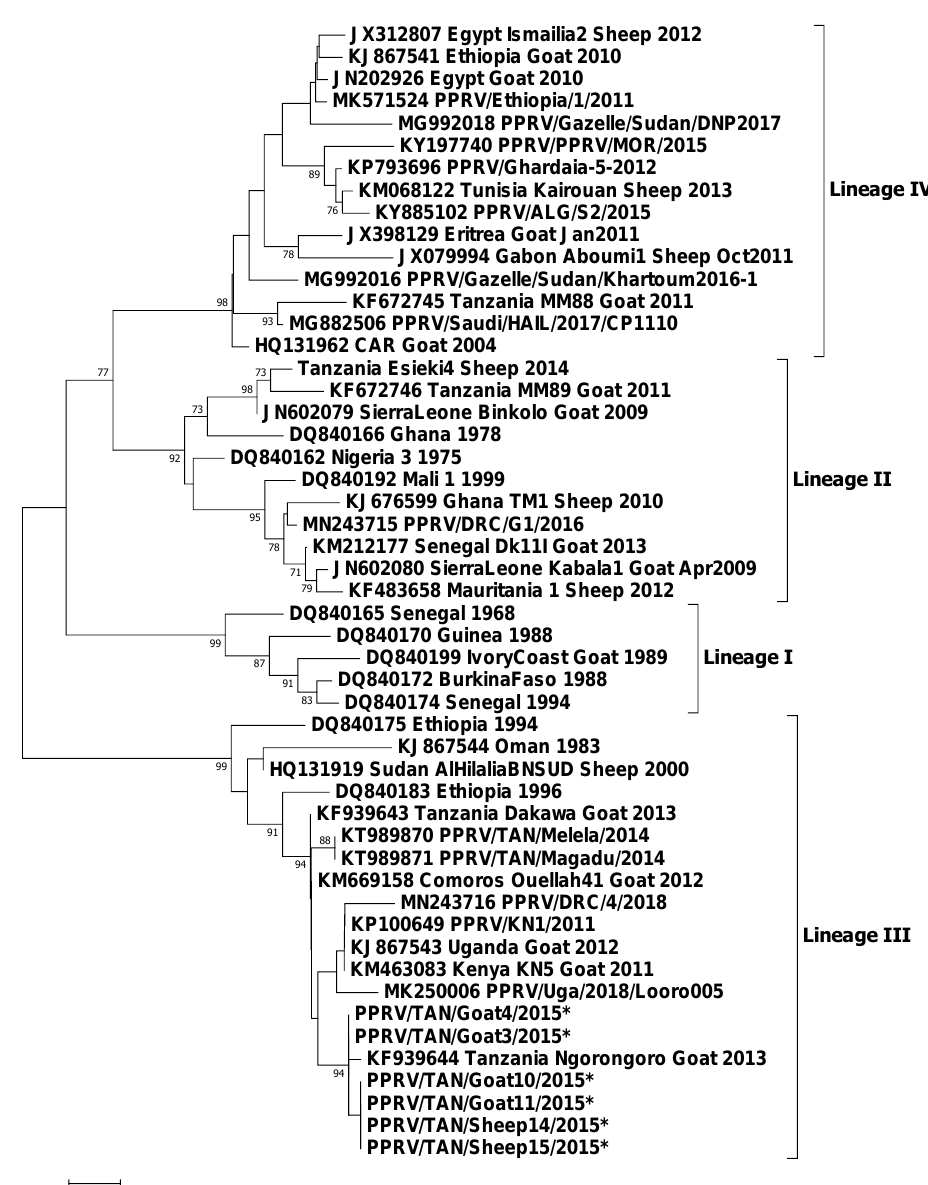
Figure 7. Neighbour-joining tree constructed on the basis of partial N gene sequences of the peste des petits ruminants virus (PPRV). The tree shows the relationships among the African PPRV isolates. The scale bar indicates nucleotide substitutions per site. The Kimura 2-parameter model with percentage of replicate trees in which the associated taxa clustered together in the 1000 bootstrap replicates is shown next to the branches. The six sequences generated in this study (accession numbers: MT181842-47) are indicated by an asterisk at the end of the taxon name. The taxon name of the sequences retrieved from GenBank contains the accession number followed by the name of the country and the year of isolation.